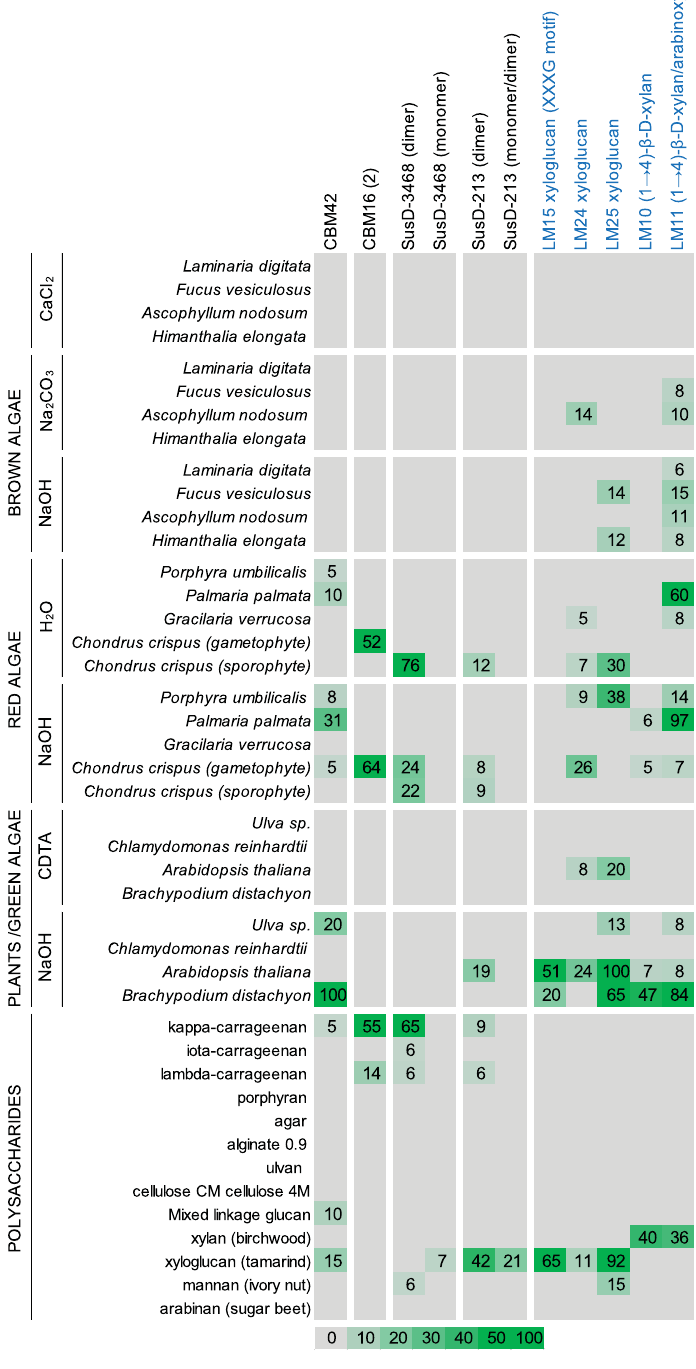
(gametophytes only produced κ -/ ι -carrageenans and sporophytes only produced λ -carrageenans) 31 . The results obtained indicated that CBM16(2) preferentially binds κ -carrageenans (Figs 3 and 4). In the case of the SusD-like proteins, the dimers were much more effective to bind ligands than the momoners (Figs 4 and 5). The ability